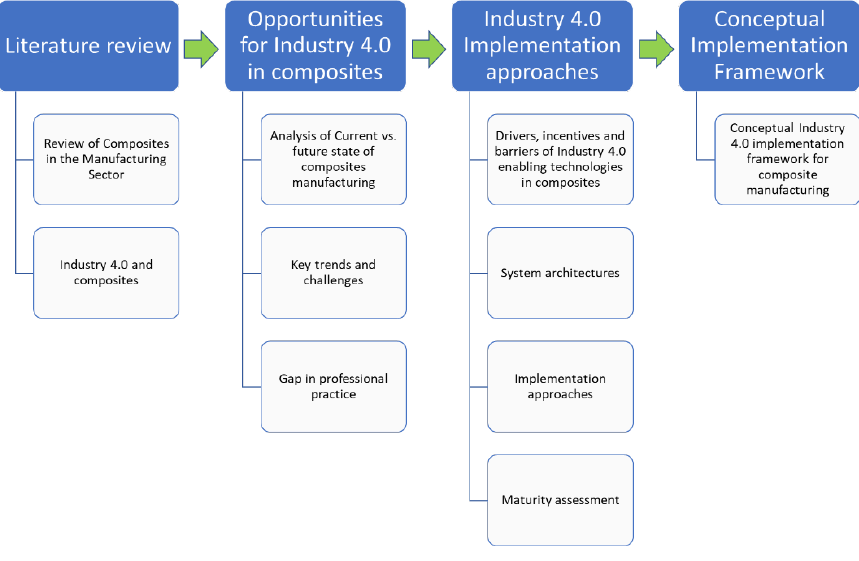
Figure 1. The research approach and aspects covered in this